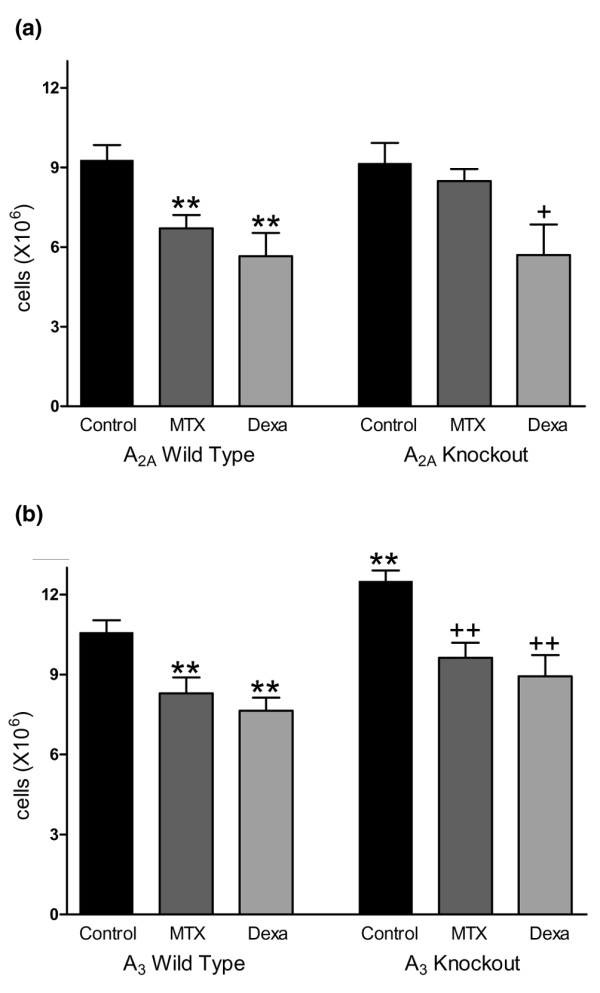
Effect of methotrexate and dexamethasone treatment on leukocyte accumulation in peritoneal exudates of mice. (a) A2A wild-type mice and A2A receptor knockout mice or (b) A3 wild-type mice and A3 receptor knockout mice either were treated with weekly injections of methotrexate (0.75 mg/kg) or saline control for 4 weeks prior to induction of inflammation or were treated with a single intraperitoneal injection of dexamethasone (1.5 mg/kg) or saline 1 hour before induction of inflammation and subsequent collection of inflammatory exudates, as described. Results are presented as the mean (± SEM) million cells per exudate. **P < 0.001 vs wild-type control mice, ++P < 0.001 vs knockout control mice, +P < 0.05 vs knockout control mice, all one-way analysis of variance (Bonferroni t test).